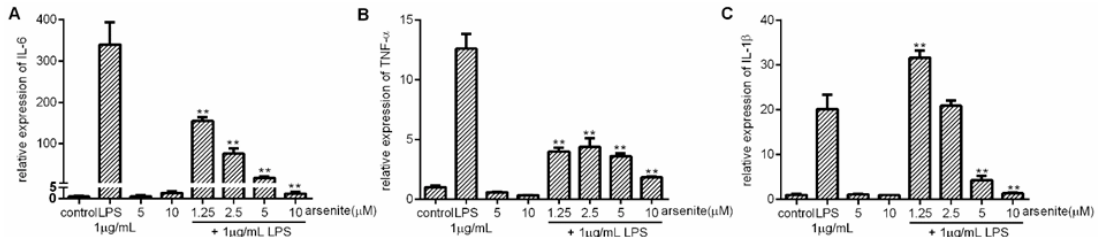
Figure 2. The inhibition of expression of LPS-induced pro-inflammatory cytokines by cell stress in 030D cells. 030D cells were treated with various concentration of arsenite (1.25 µM to 10 µM) for 16 h as indicated. Next, left unstimulated or stimulated with 1 µg/mL LPS for 6 h. mRNA expression of IL-6 ( A ), TNF- α ( B ) and IL-1 β ( C ) was measured by qPCR. Data are shown as the mean ± SD and are representative of three independent experiments. ** p < 0.01, vs. LPS alone group.